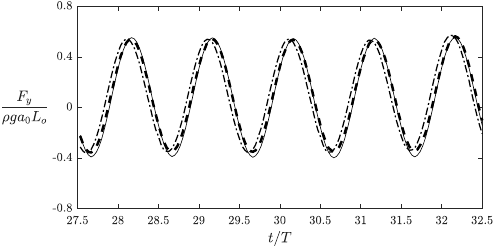
Figure 17. Time histories of dimensionless vertical force acting on the top of a bottom obstacle with d m = 0 (solid line), d m = δ m (dashed line), and d m = 3 δ m (dashed-dotted line). See Figure 13 for other model